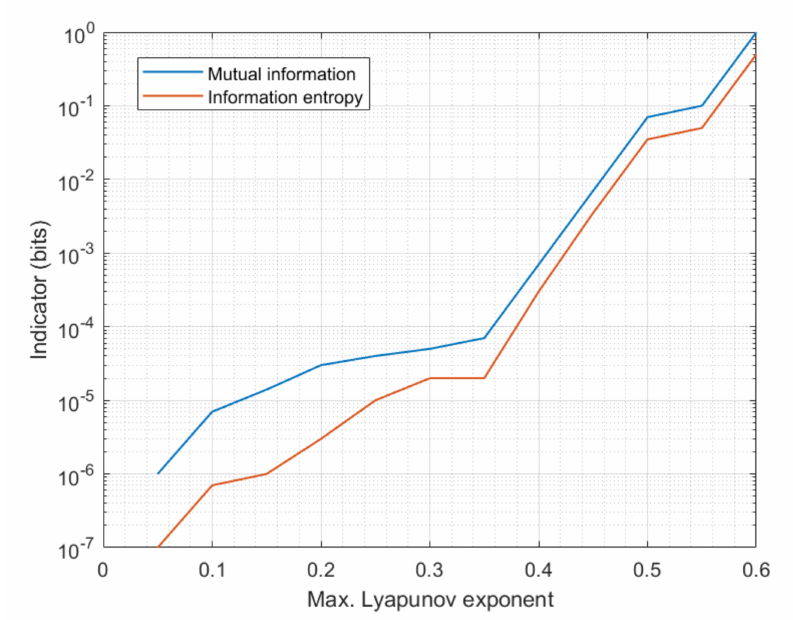
Figure 8. Mutual information between the encrypted and clear